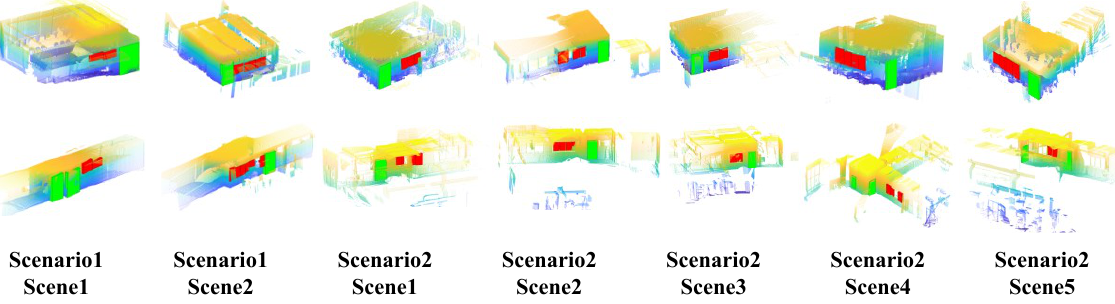
Figure 10. The extracted 3D bounding boxes of the windows and doors for each scene. The green boxes represent the door objects and the red boxes represent the window